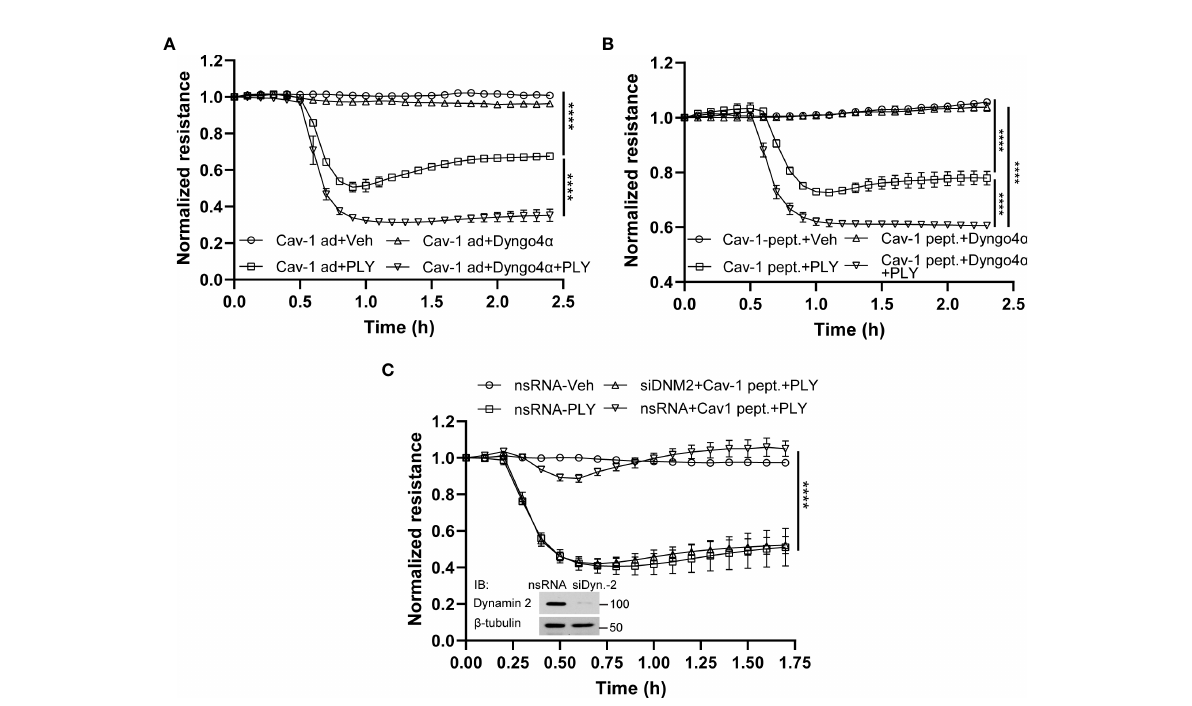
FIGURE 7 Inhibition of endocytosis attenuates the protective effect of Cav-1 and caveolin-1 scaffolding domain peptide on HULEC5 a barrier function against PLY-induced endothelial barrier disruption. (A) The inhibitor of dynamin, Dyngo4 a , decreased the protective effect of Cav-1 against PLY- induced barrier dysfunction. HULEC5 a cells were transduced Cav-1 adenovirus for 24 hours and treated with vehicle or10 µM Dyngo4 a for 4 hours prior to PLY (60 ng/mL) administration (n=3). ****P<0.0001, Cav-1 ad + PLY vs. Cav-1 ad.+ Dyngo 4 a + PLY. (B) The dynamin inhibitor, Dyngo4 a , diminishes the protective effect of the Cav-1 scaffolding domain peptide against PLY-induced barrier disruption. HULEC5 a cells were transduced with DMSO (Ctrl) or the Cav-1 scaffolding domain peptide (Cav-1 peptide) for 24 hours prior to PLY treatment (n=3). ****P<0.0001. (C) Loss of dynamin2 expression reduces the protective effects of the Cav-1 scaffolding domain peptide against PLY-induced barrier disruption. HULEC5 a cells were treated with either non-speci fi c or Cav-1 speci fi c siRNA for 24 hours and cells were treated with vehicle (DMSO) or Cav-1 scaffolding domain peptide (Cav-1 peptide) for an additional 24 hours prior PLY (60 ng/mL) treatment. TER changes were monitored over time (A – C) (n=3), ****P<0.0001, two-way ANOVA (with Tukey ’ s multiple comparisons test). ( Inset : western blot analysis of dynamin-2 silencing, b - tubulin was used as loading